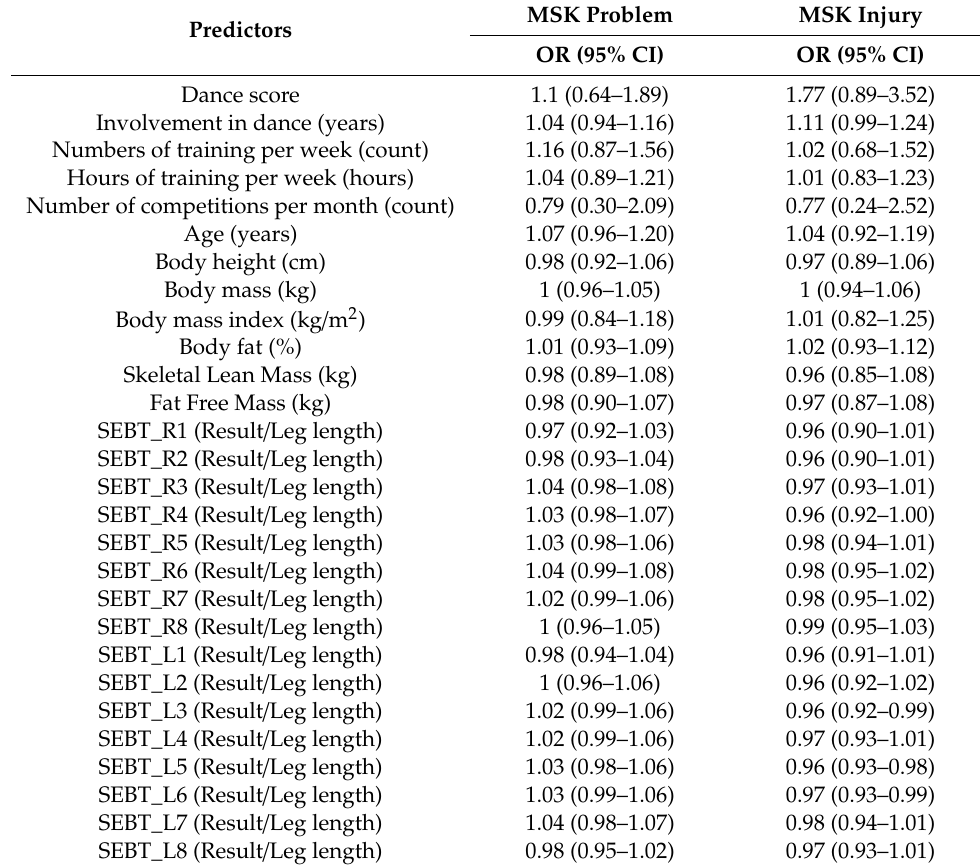
Table 4. Correlates of musculoskeletal (MSK) injury and problem in hip hop dancers as obtained by Oslo Sports Trauma Research Center Overuse Injury Questionnaire—multinomial regression univariate correlations between predictors and criteria (“no MSK problem / injury” as reference value)—adjusted for gender and previous injury